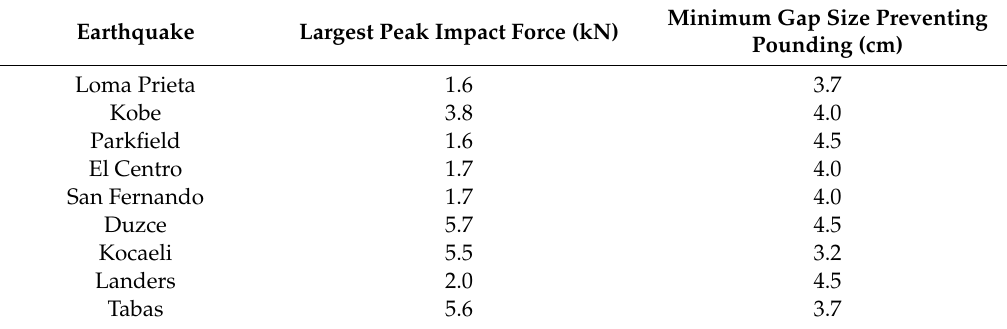
Figure 8. Peak impact force with relation to gap size between buildings under di ff erent earthquakes. Table 4. Results for di ff erent gap sizes between